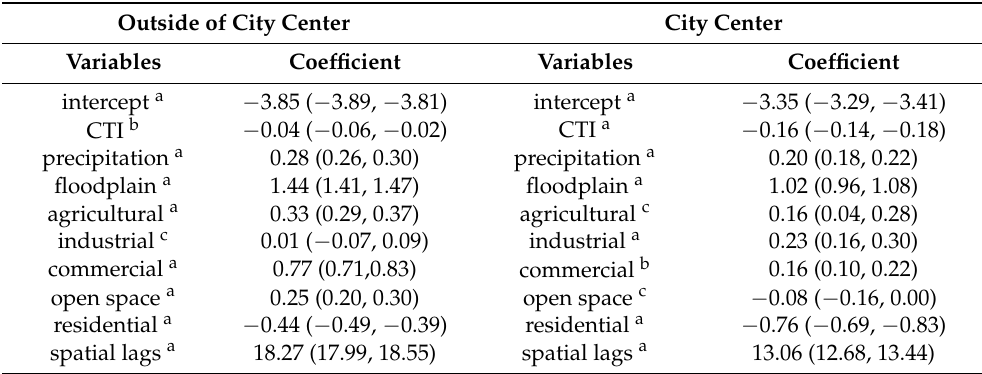
a : indicates significance with 99% confidence. b : indicates significance with 95% confidence. c : indicates